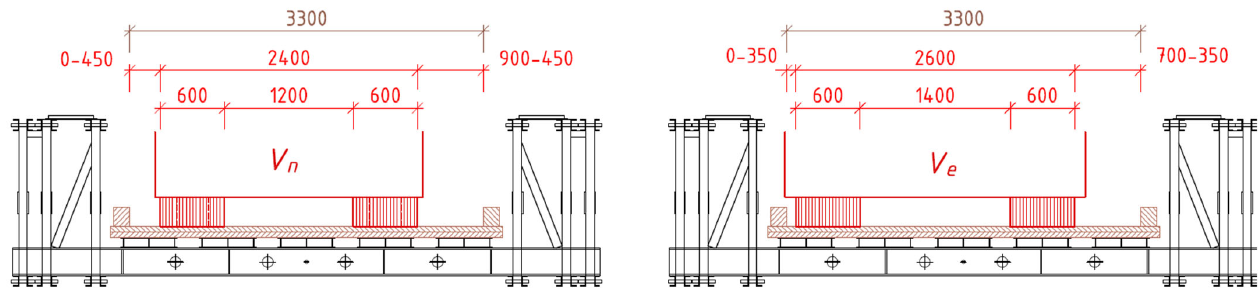
Figure 13. Positions of heavy vehicles within cross ‐ section: V n on the left, and V e on the right. The longitudinal placement of the load patterns was applied on the basis of moving load module considering their possible relief effects along the bridge. Hence, up to more than a hundred positions were analysed for each Bailey bridge model, depending on the BB system configuration.